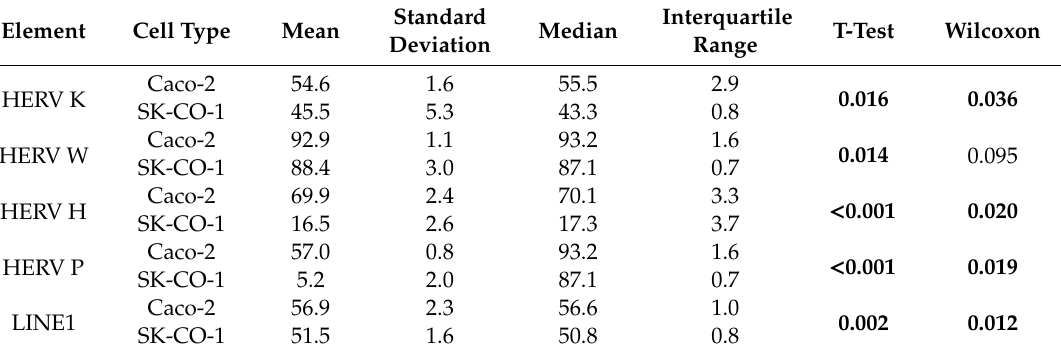
Table 1. Association of HERV LTRs methylation between untreated Caco-2 and SK-CO-1 cell lines. T-test and Wilcoxon p -values in bold are statistically significant.